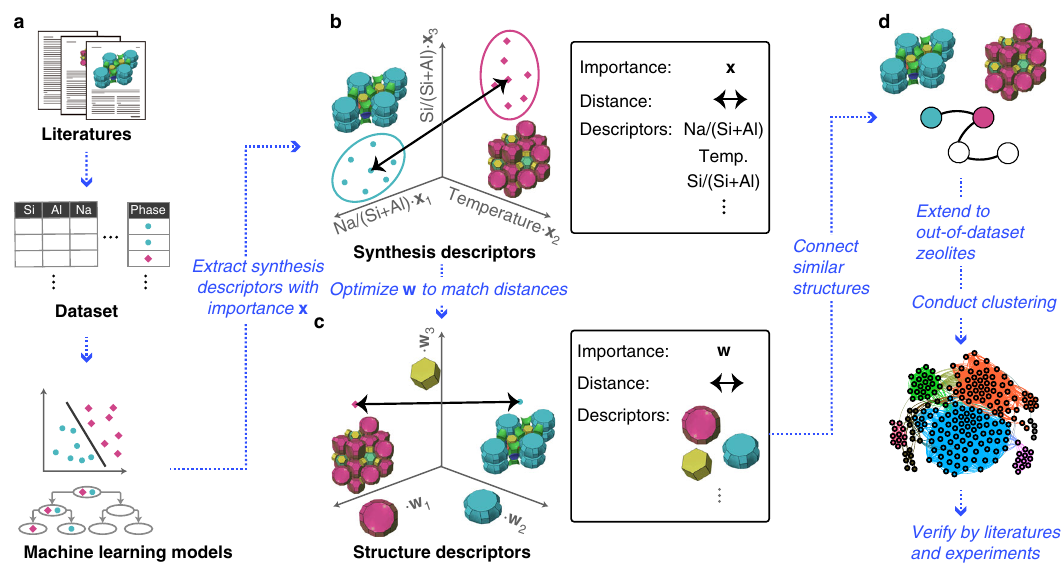
Fig. 1 Work fl ow to link synthesis descriptors to structure descriptors in zeolites. a Machine learning models were constructed from experimental records in the literature; the dataset contains synthesis descriptors and corresponding outcomes. b Synthesis descriptors extracted from the machine learning models mapped the synthesizable domains of zeolites onto a multidimensional (kinetic) phase diagram. The weight, x i , indicates the importance of each synthesis descriptor, i , obtained from the machine learning models. The synthesis similarity is represented by the distance between the centers of the synthesis conditions for each phase. c Structure descriptors de fi ne the structural similarity in a multidimensional space representing the presence or absence of building units. To link the synthesis descriptors to the structure descriptors quantitatively, the weight, w j , for each structure descriptor, j , was optimized to yield the structural similarity (arrow in c ) close to the synthesis similarity (arrow in b ). d A network was constructed by connecting structurally similar zeolites based on the structure descriptors. The resulting clustering was veri fi ed with historical data and our